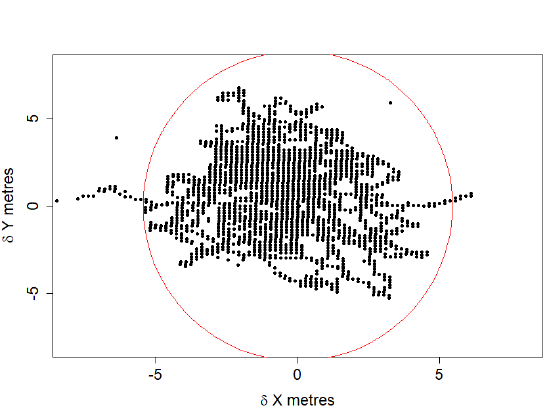
Figure 8. Horizontal error for 44 h of measurements.